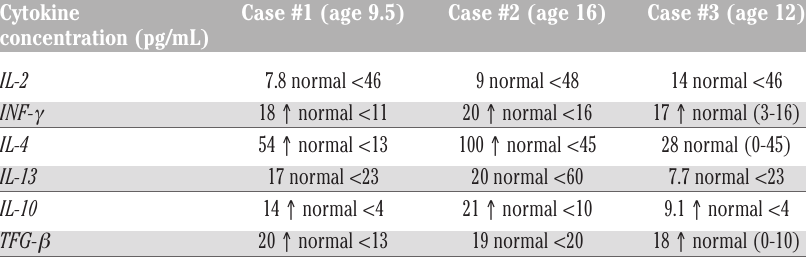
Table1. Cytokine assessment in the 3 pediatric